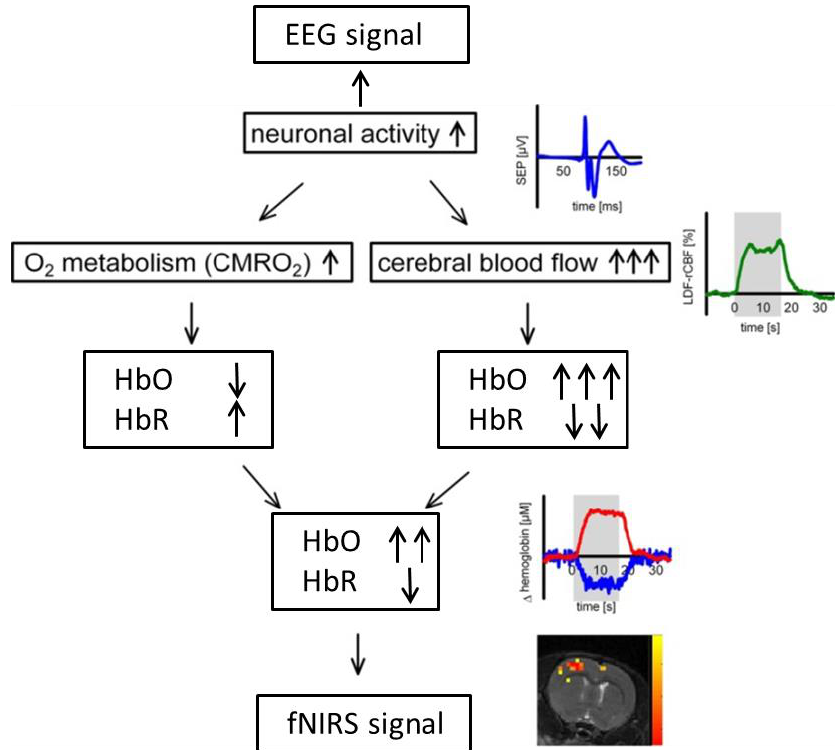
Figure 2. Demonstration of neurovascular coupling.